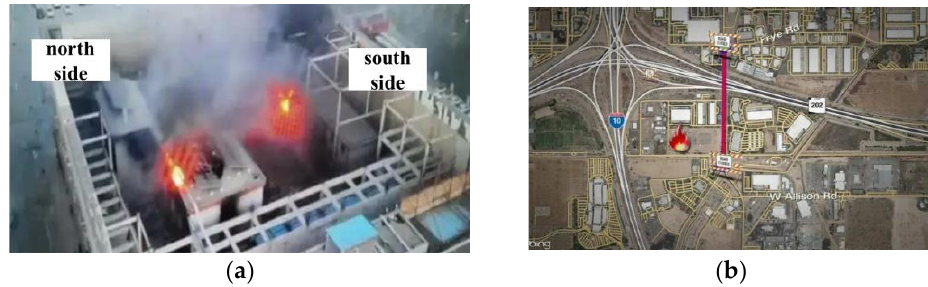
Figure 6. Fire accident at energy storage power stations: ( a ) Beijing; ( b ) Arizona.